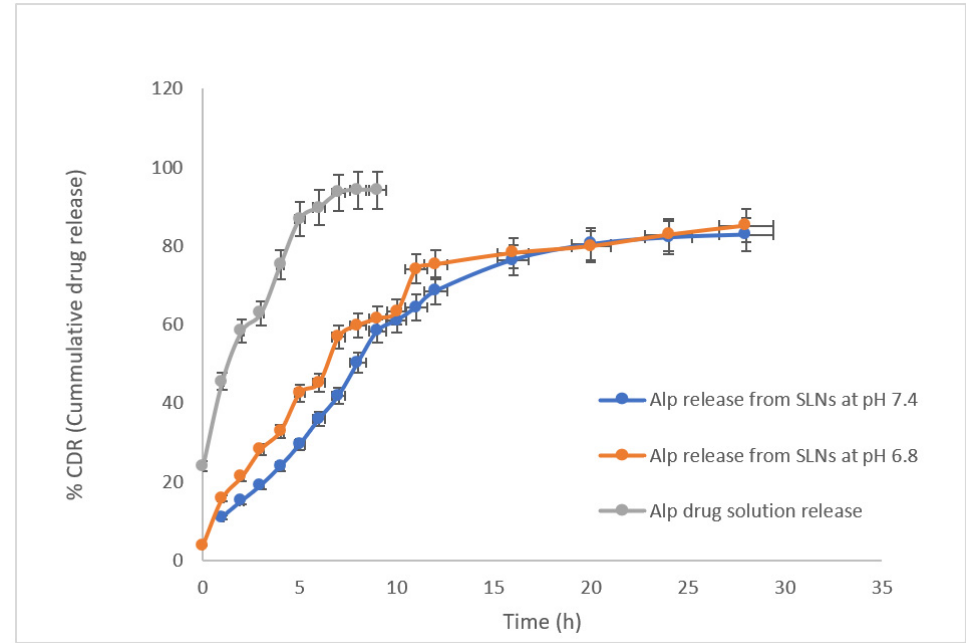
Figure 8. In vitro release profile of ALP drug solution & AF6.